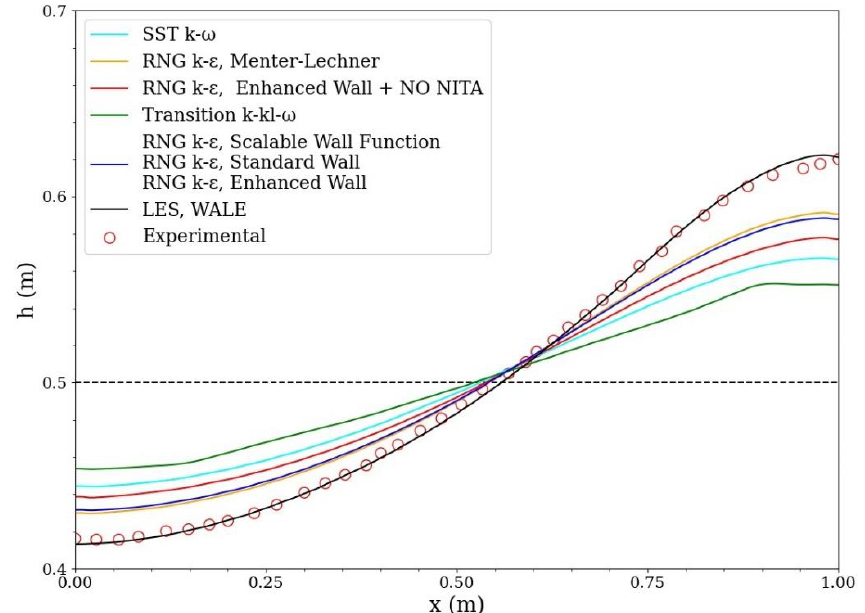
Figure 2. Free surface elevation along the tank length at t = 3.55 s (3 periods T ). The dotted line represents the initial free surface elevation.